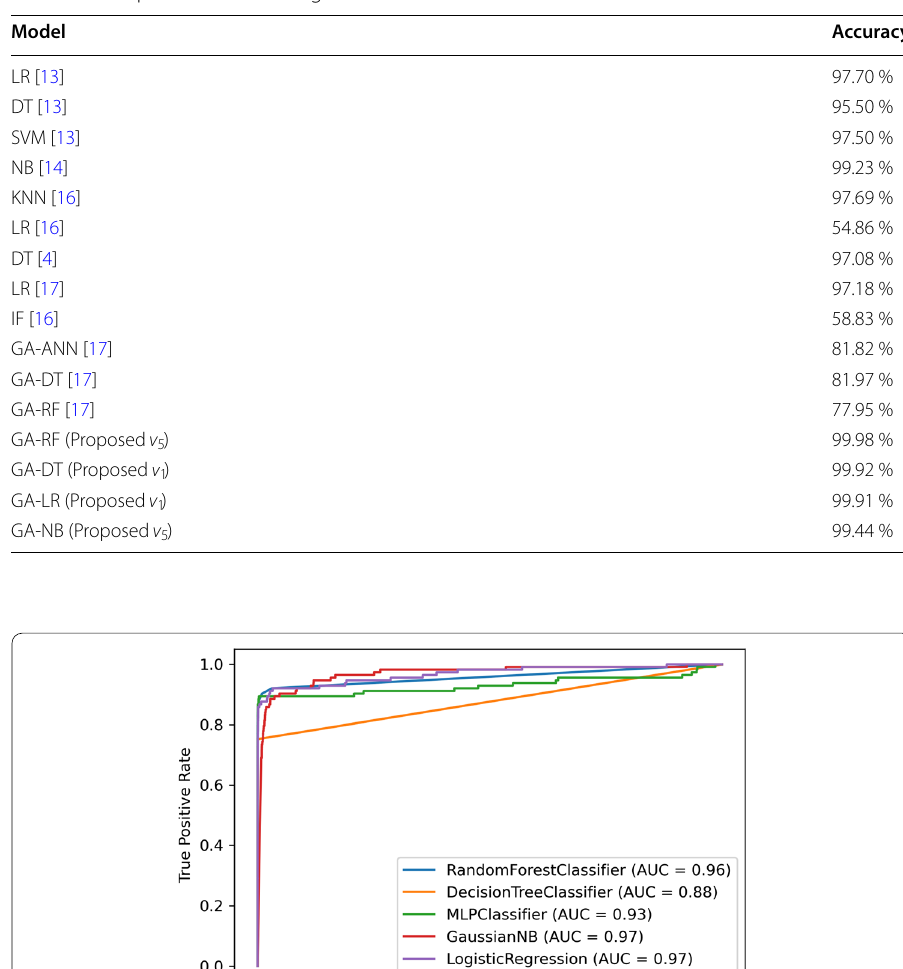
Table 9 Comparison with existing methods